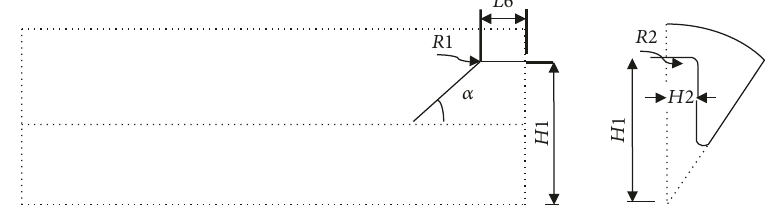
Figure 2: Fin geometry con fi guration in length and star cross section of fi n.